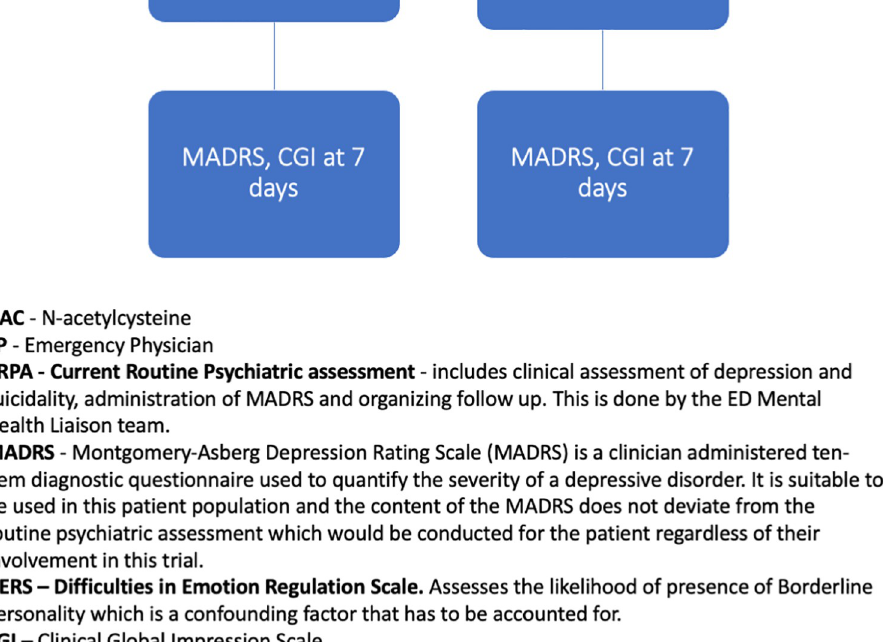
PLOS ONE | https://doi.org/10.1371/journal.pone.0263149 January 28,